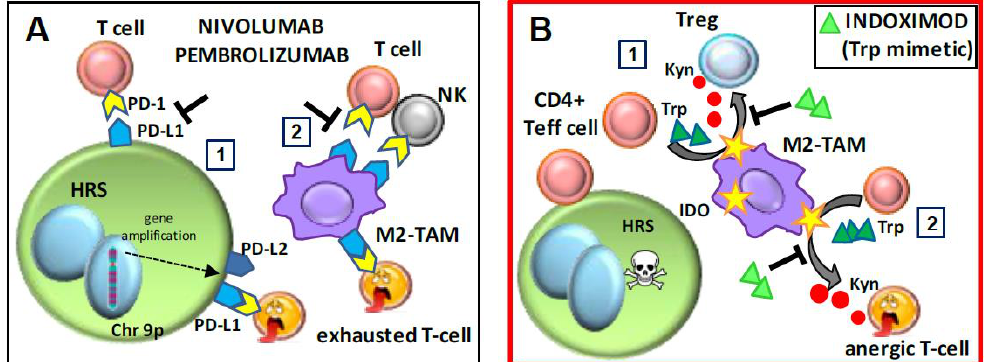
Figure 2. Mechanism of action of the checkpoint inhibitors nivolumab and pembrolizumab, and